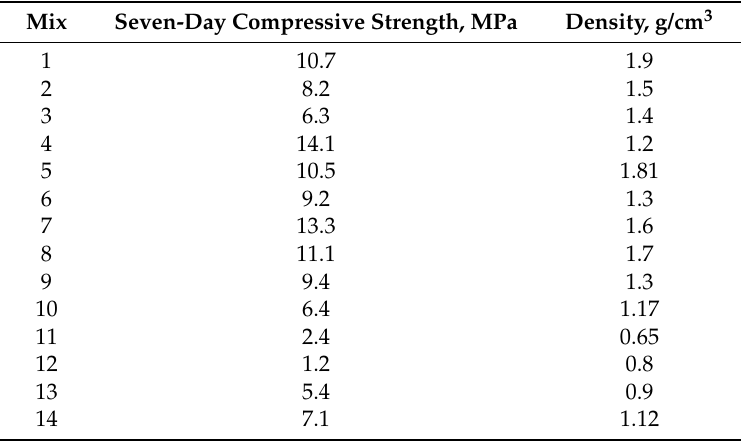
Table 2. Mix designs and performance characteristics of the aerated slurry.